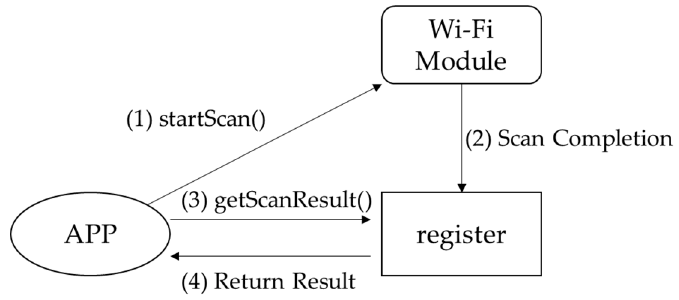
Figure 1. Simplified procedure for Wi-Fi signal scanning using Android.